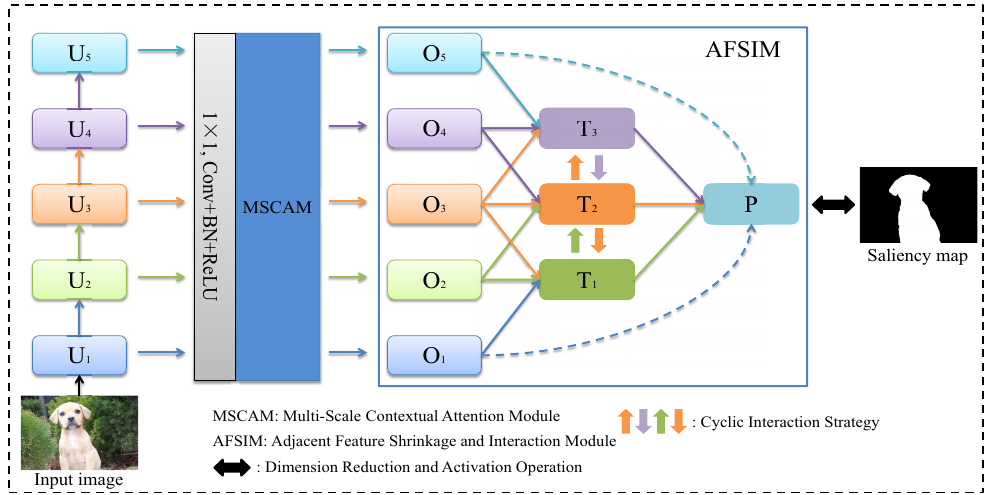
Figure 3. The complete architecture of the proposed GSCINet method for fast and accurate salient object detection, consisting of a Multi-Scale Contextual Attention Module (MSCAM) and an Adjacent Feature Shrinkage and Interaction Module